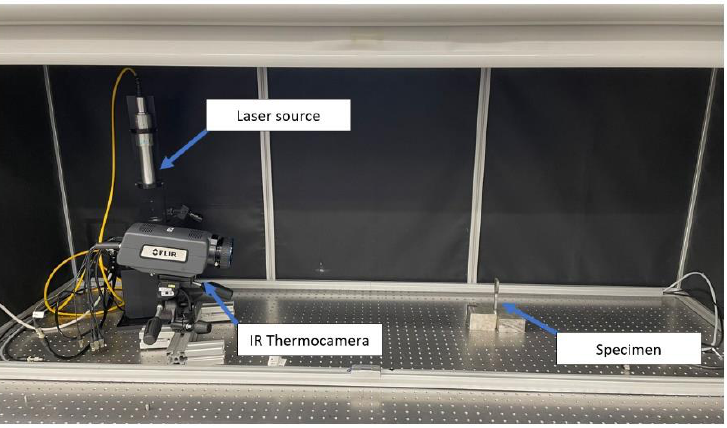
Figure 1. Experimental equipment.